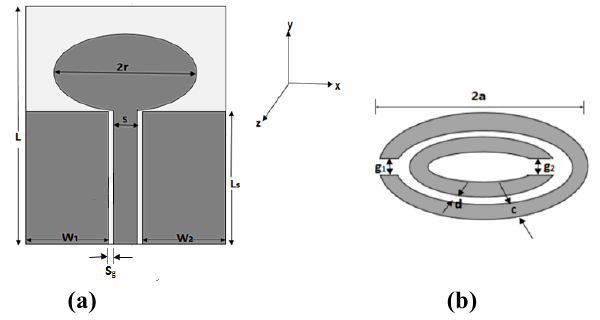
Figure 1: (a) CPW UWB elliptical planar monopole antenna and (b) ESRR structure. Table 1: The design parameters of the proposed antenna